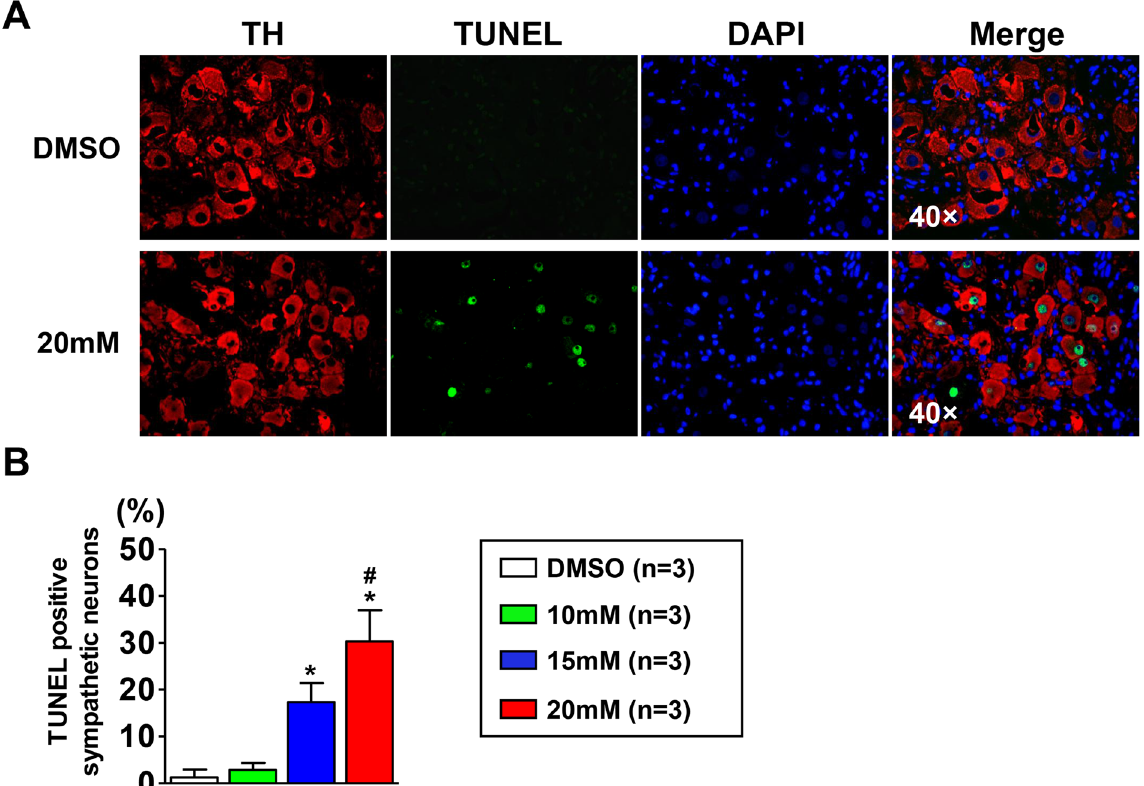
Figure 6. Effect of Nav1.8 channel block on apoptosis of sympathetic neurons in LSG. ( A ) Representative images showing double-immunofluorescence staining for TH (red) and TUNEL (green) in LSG from DMSO group and 20 mM A-803467 group. ( B ) Quantification of the sympathetic neuron apoptosis (n = 3, * p < 0.05 vs DMSO group, # p < 0.05 vs 10 mM group). TH = Tyrosine